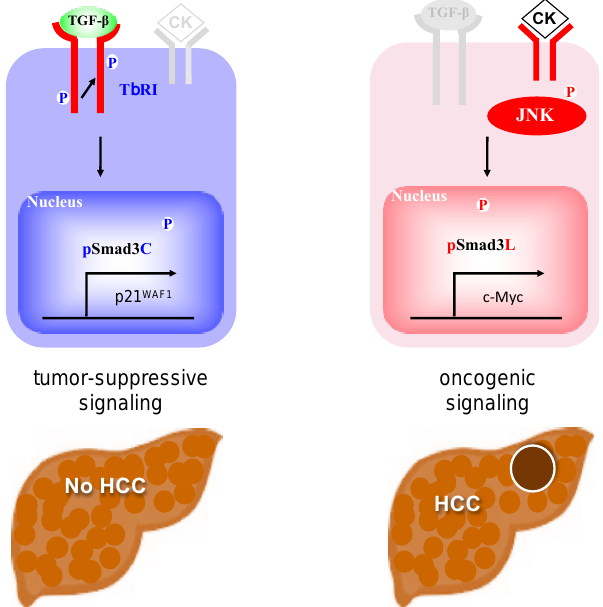
Figure 7. Pro-inflamatory cytokine (CK) such as tumor necrosis factor (TNF)- α and interleukin 6 (IL-6) shifted hepatic transforming growth factor (TGF)- β signaling from the tumor-suppressive pSmad3C pathway to the oncogenic c-Jun N-terminal kinase (JNK)-dependent pSmad3L pathway in nonalcoholic steatohepatitis (NASH) liver.